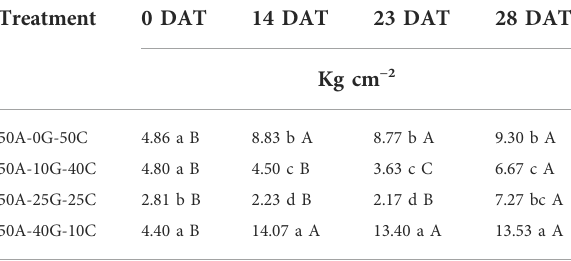
TABLE 6 Effect of treatment group on cohesivity at 0, 14, 23, and 28 days after treatment (DAT).